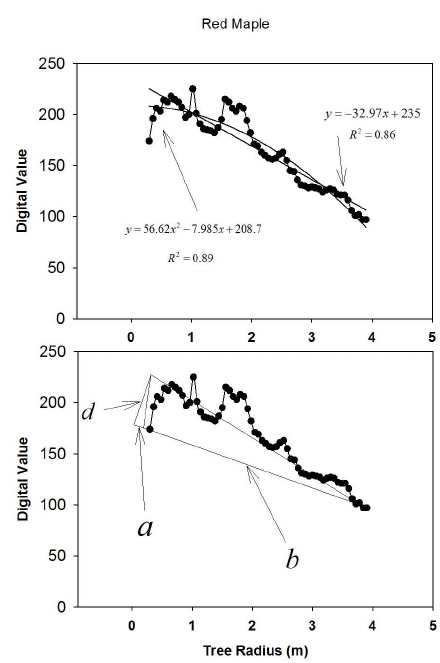
Figure 6. ( Top ): the linear and second order polynomial fit; ( Bottom ): the single node triangles in the Vectorization of the profiles.